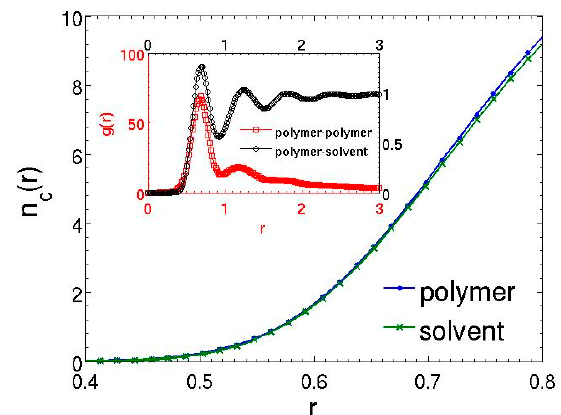
Figure 4. Time-averaged coordination numbers for polymer and solvent beads in the athermal solution for A ps = − 40. The inset plots the time-averaged polymer–polymer and polymer–solvent radial distribution functions. The lines are only guide to the eyes.